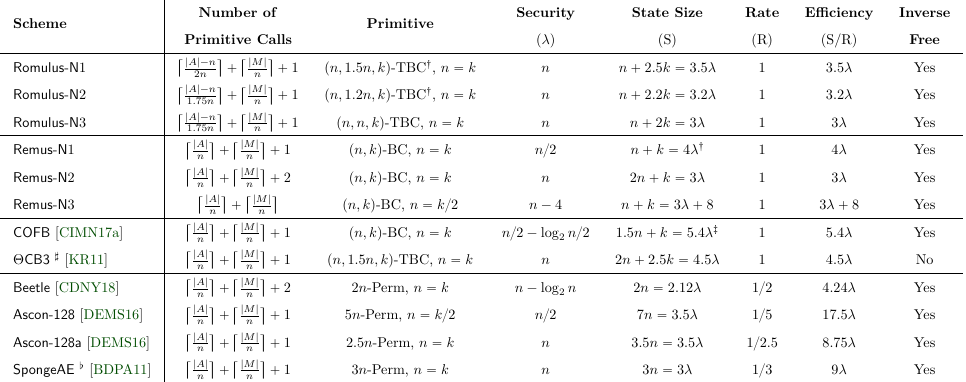
Table 1: Efficiency comparison of nonce-based AE schemes. λ is the bit security level of a mode. Here, p n, k q -BC is a block cipher of n -bit block and k -bit key, p n, t, k q -TBC is a TBC of n -bit block and k -bit key and t -bit tweak, and b -Perm is an b -bit cryptographic